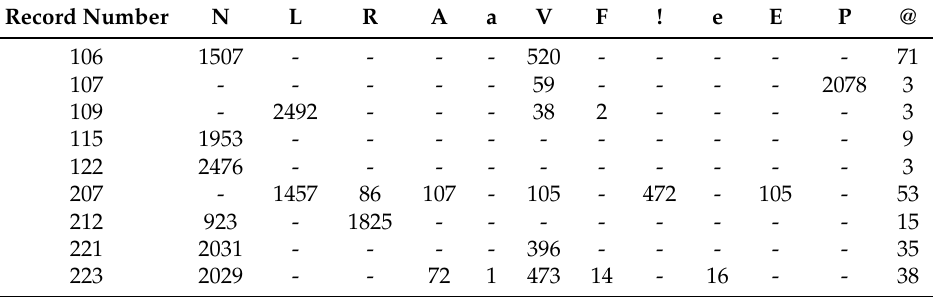
Table 5. Characteristics of each record selected from the MIT-BIH arrhythmia